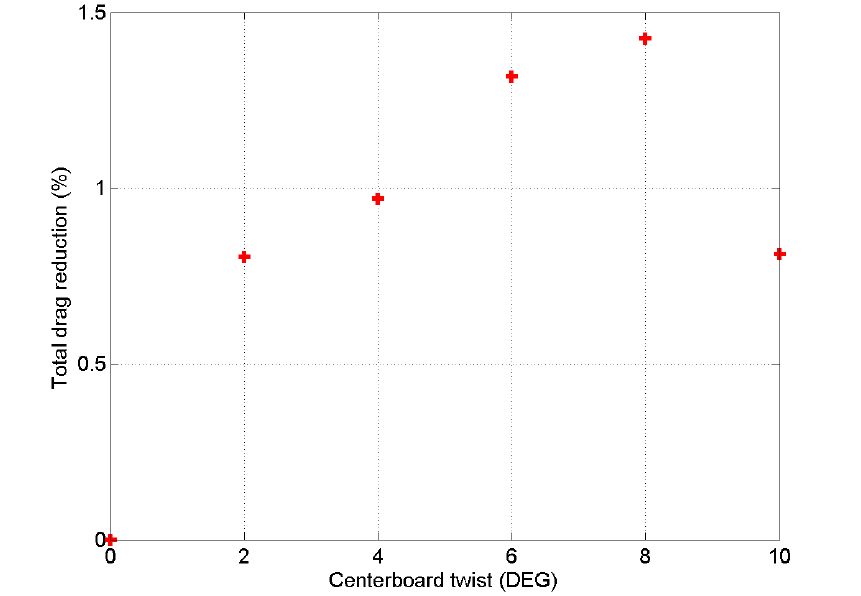
Figure 4. Parametric twist